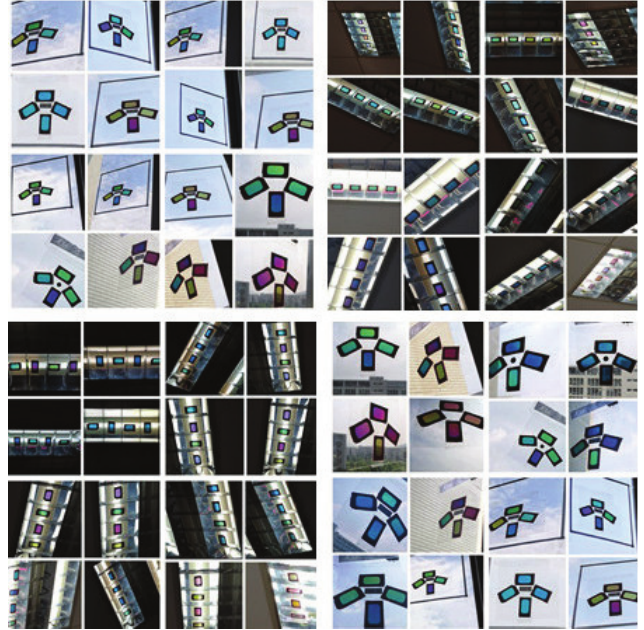
Figure 6. The photo of the color polarizer in different